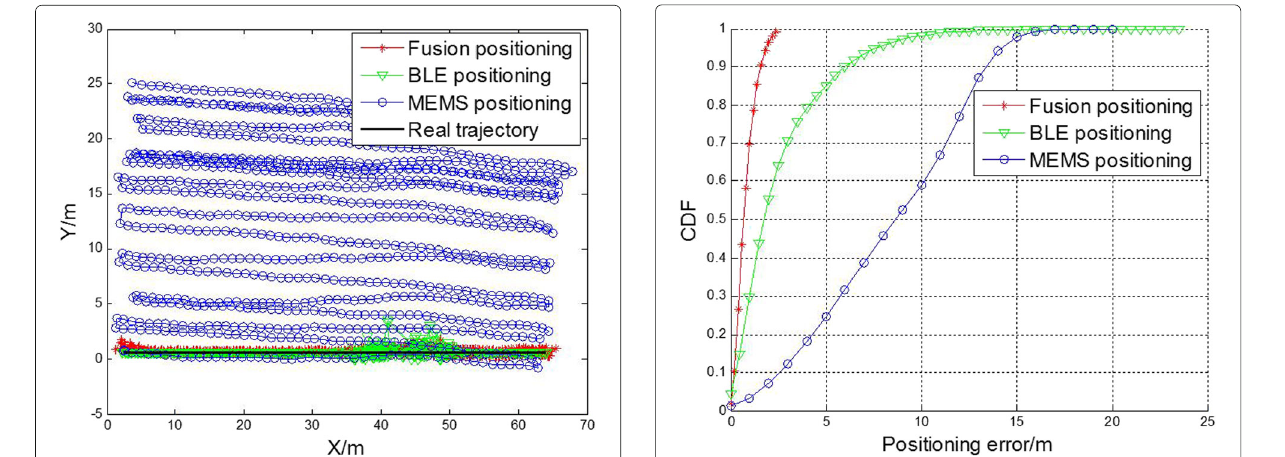
Fig. 36 CDF of positioning errors under irregularshape of